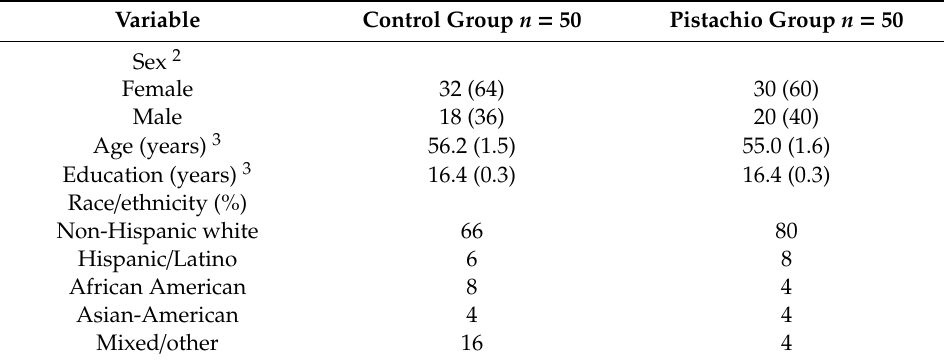
Table 1. Characteristics of study participants in the weight loss intervention 1 .